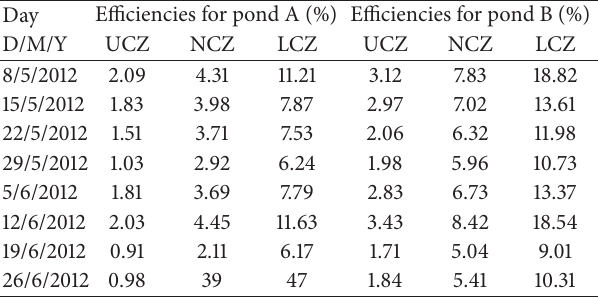
Table 3: Efficiencies variation of three different zones of solar ponds “A” and “B”.